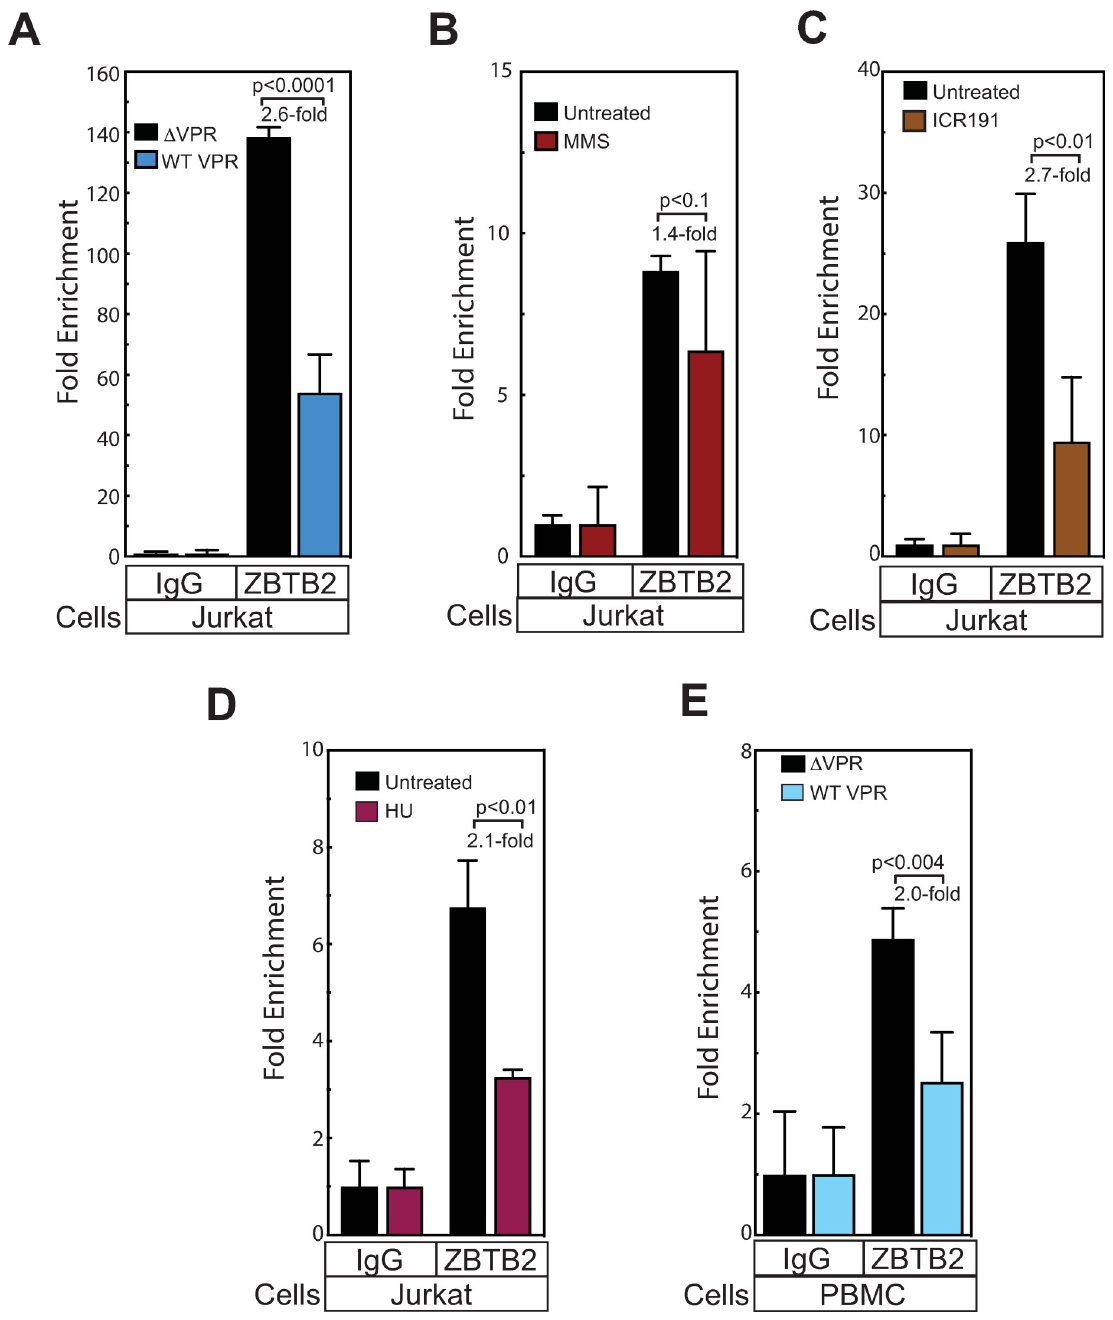
Fig 12. Activation of the Vpr/ATR pathway impairs ZBTB2 recruitment to the HIV-1 promoter. (A) ChIP analysis of ZBTB2 recruitment to the HIV-1 promoter in Jurkat cells infected with an HIV-1 NL43 variant that either expresses Vpr or lack Vpr. (B) ChIP analysis of ZBTB2 recruitment to the HIV-1 promoter in Jurkat cells treated with 8 μ M methyl methanesulfonate (MMS) (C) 25 mM Hydroxyurea or (D) 4 μ g/ml ICR-191 and infected with an HIV-1 vector. (E) ChIP analysis of ZBTB2 recruitment to the HIV-1 promoter in primary PBMCs stimulated with CD3/CD28 beads and infected with an NL43 variants either expresses or lacks Vpr. Immunoprecipitation and Real-time PCR analysis were performed and normalized to input controls and reported as percent of starting material for immunoprecipitation. Fold enrichment of experimental IPs relative to IgG controls is reported below the graph. The data shown are the average mean values obtained in an experiment performed with quadruplicate samples and are representative of three independent experiments. Error bars indicate the standard deviation of the data in all panels. P-values were calculated using a standard Student’s t-test and significant changes relative to relevant bracketed comparisons indicated.